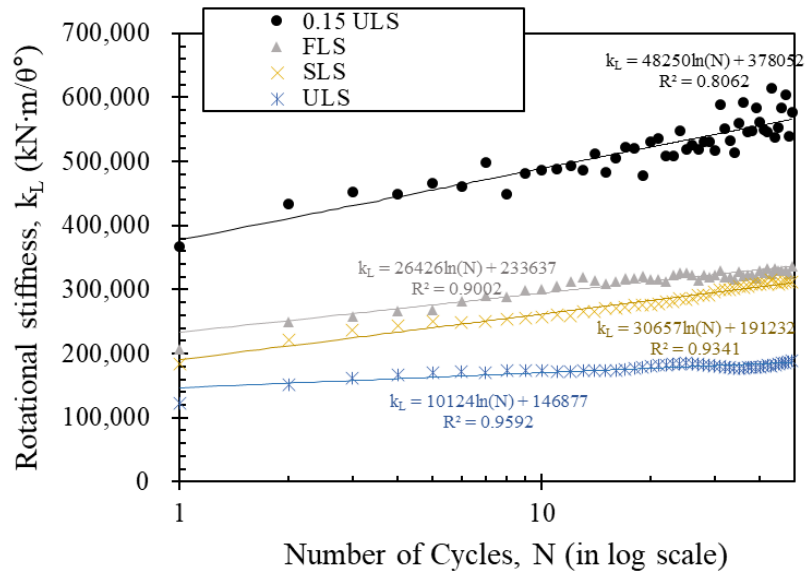
Figure 14. Prediction curves of cyclic stiffness of site demonstration OWT.